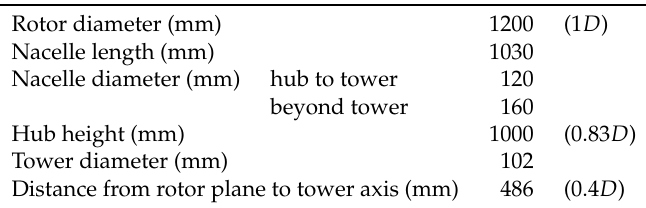
Table 1. Key turbine dimension (from [17]).